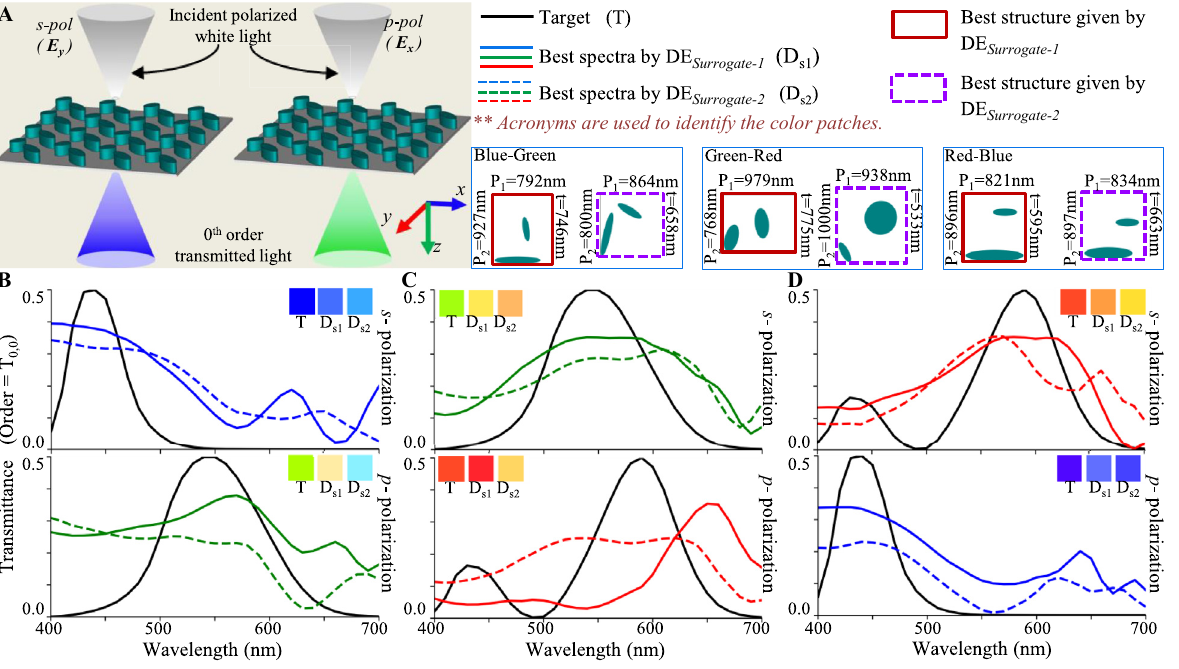
and DE . Surrogate-1 Surrogate-2 and Surrogate-1